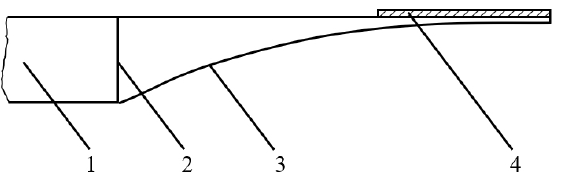
Figure 1. Acoustic Black Hole (ABH) vibration absorber, technical principle as in Krylov (2004) [2]: 1 = structure to be damped, 2 = base area A o , 3 = tapered waveguide and 4 = damping layer. Since the mathematical singularity with wave velocity c → 0 is technically not feasible, a damping layer is added for a reflectionless termination.